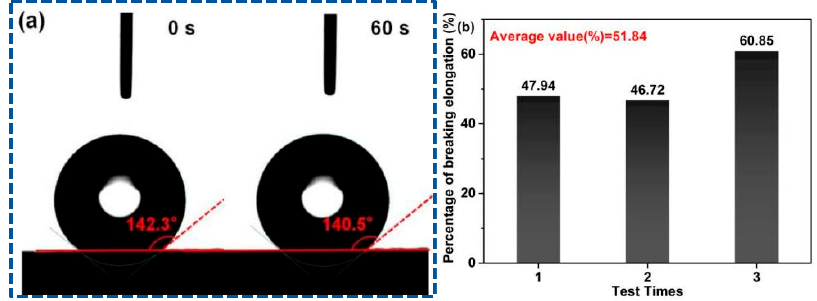
Figure 6. ( a ) Contact angles at 0 s and 60 s, and ( b ) percentage of breaking elongation of PFs.